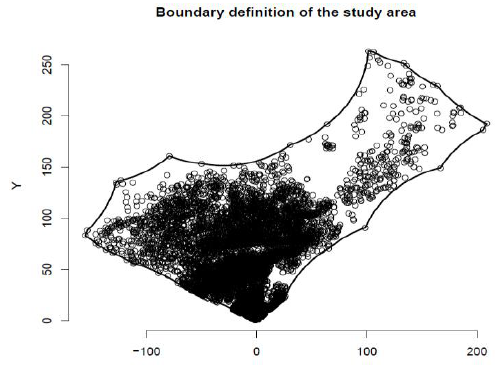
Figure 5. Working area from alpha cancave hull of